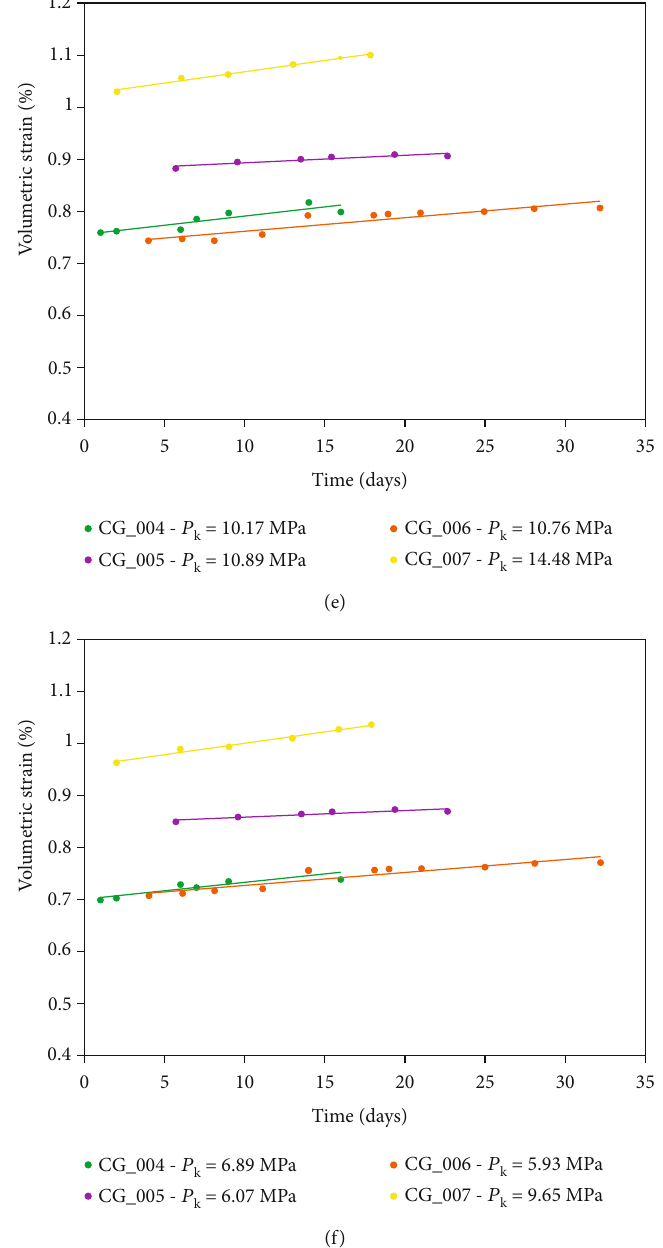
Figure 9: Comparison of permeability and volumetric strain measured during each permeability test. High P compared with time (a) and number of cycles (c) elapsed, while low P k permeability measurements are compared with time (b) and number of cycles (d) elapsed. Volumetric strain recorded at high P k (e) and low P k (f) permeability measurements is compared with time